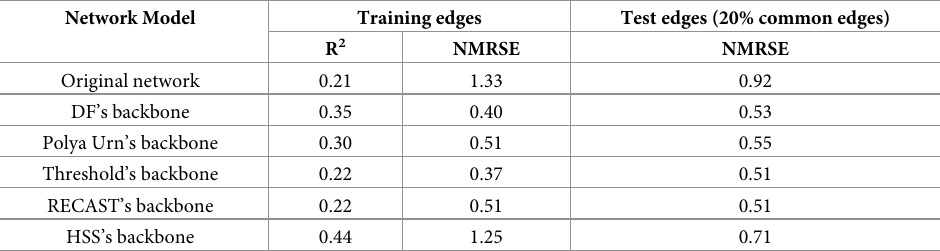
Table 5. Coordinated behavior on WhatsApp: Contextual evaluation of backbones by regression